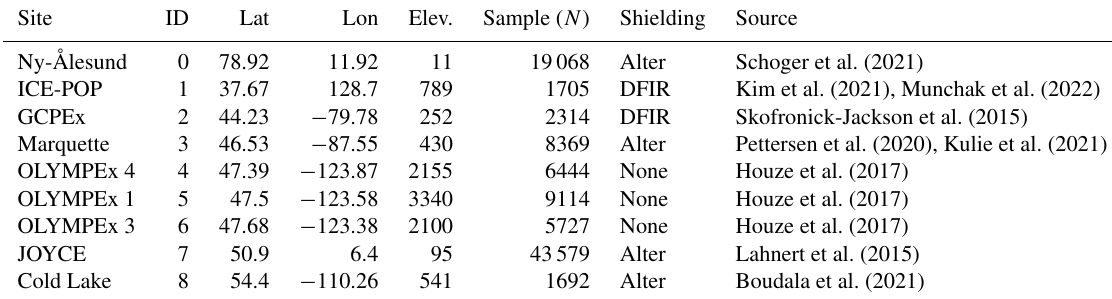
Figure 1. Observational input data locations and temporal coverage periods. (a) Geographic study site locations. (b) Timeline of observational coverage (periods of active precipitation) for each site from 2012 to 2020. Table 1. Summary of in situ study site locations, identifiers, and observational